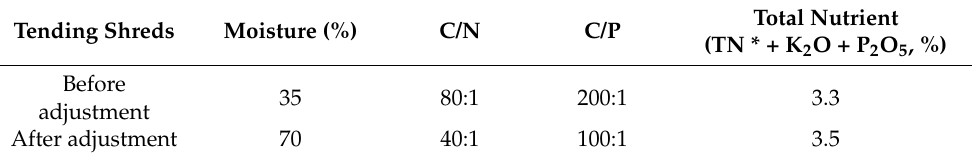
Total Nutrient (TN * + K 2 O + P 2 O 5 , %)